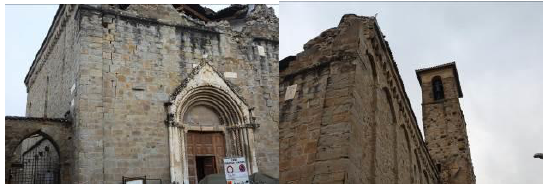
Figure 3. Two terrestrial images acquired in the first